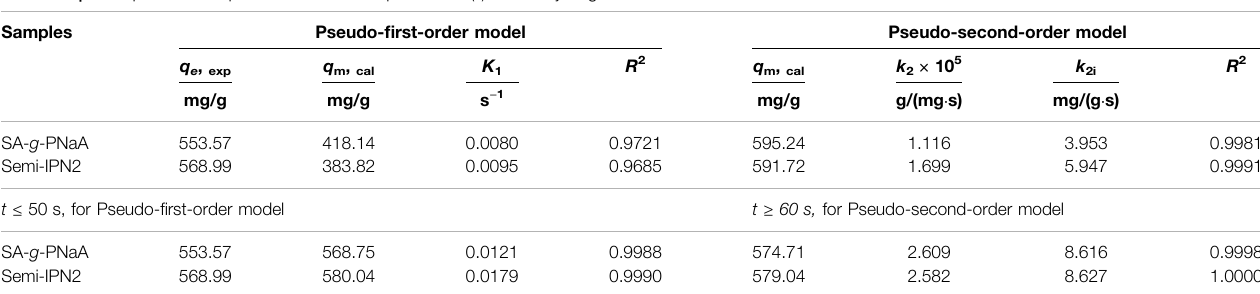
TABLE 3 | Adsorption kinetic parameters for adsorption of Pb(II) on the hydrogel.